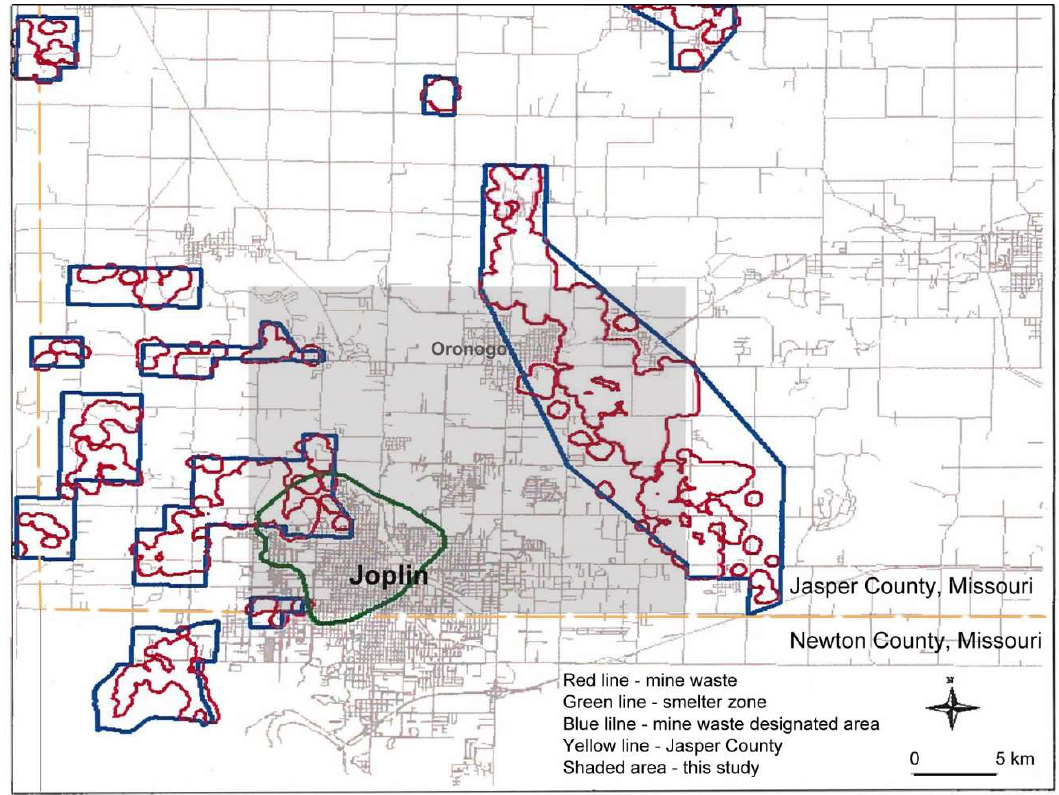
Figure 2. Extent of historic chat piles in the Oronogo-Duenweg Superfund site and smelter zone. The area of this study is shown shaded. Modified from the U.S. Environmental Protection Agency (USEPA) [27].